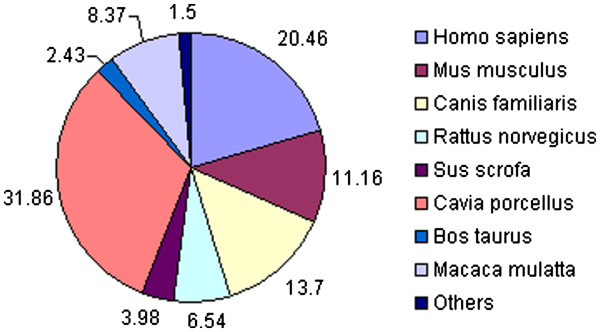
 Distribution of probes in 44 K GPOM. The figure depicts the % distribution of oligonucleotide probes present in the 44 K guinea pig oligonucleotide microarray. The 60mer oligonucleotide probes were designed based on several mammalian species including human (Homo sapiens), mouse (Mus musculus), rat (Rattus norvegicus), rhesus monkey (Macaca mulatta), dog (Canis familiaris), horse (Equus caballus), cat (Felis catus), sheep (Ovis aries), pig (Sus scrofa), chimpanzee (Pan troglodyte), chinchilla (Chinchilla lanigera), gray-tailed opossum (Monodelphis domestica), cattle (Bos taurus) and guinea pig (Cavia porcellus). The % representation of a particular species is calculated with respect to the total number of probes in the array. The figure does not show some of the mammalian species separately for which, the % representation is < 1% and are collectively labelled as – others. Number wise distribution of probes from all the species is given in Table
 1.